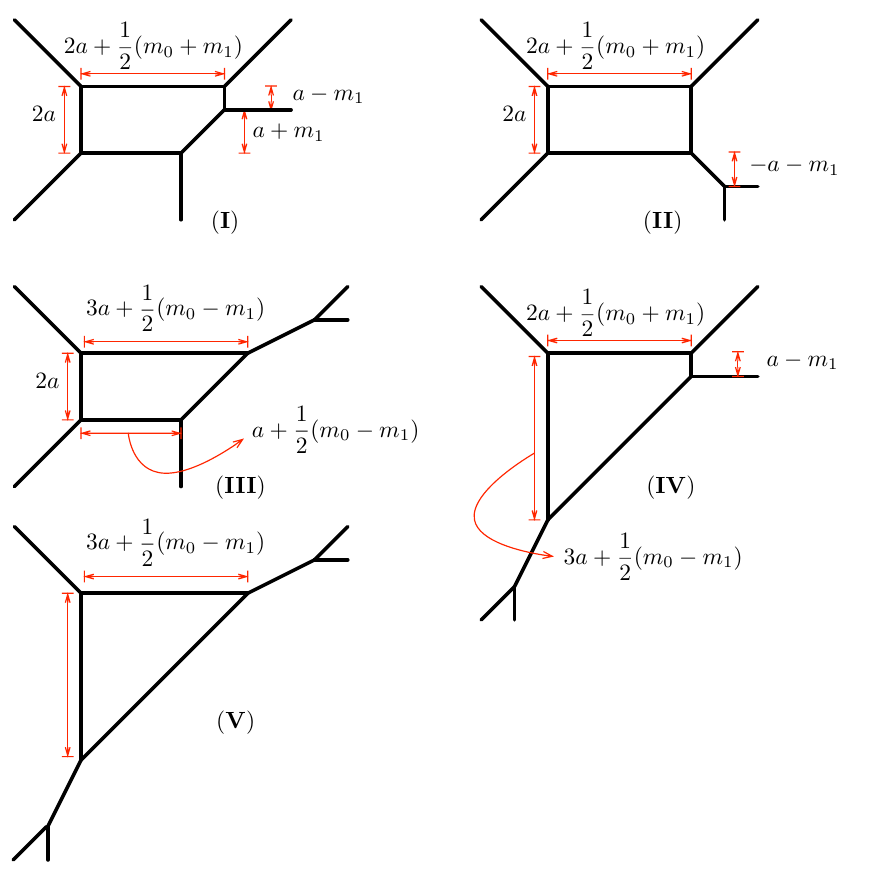
Figure 3 . All possible distinct phases of E